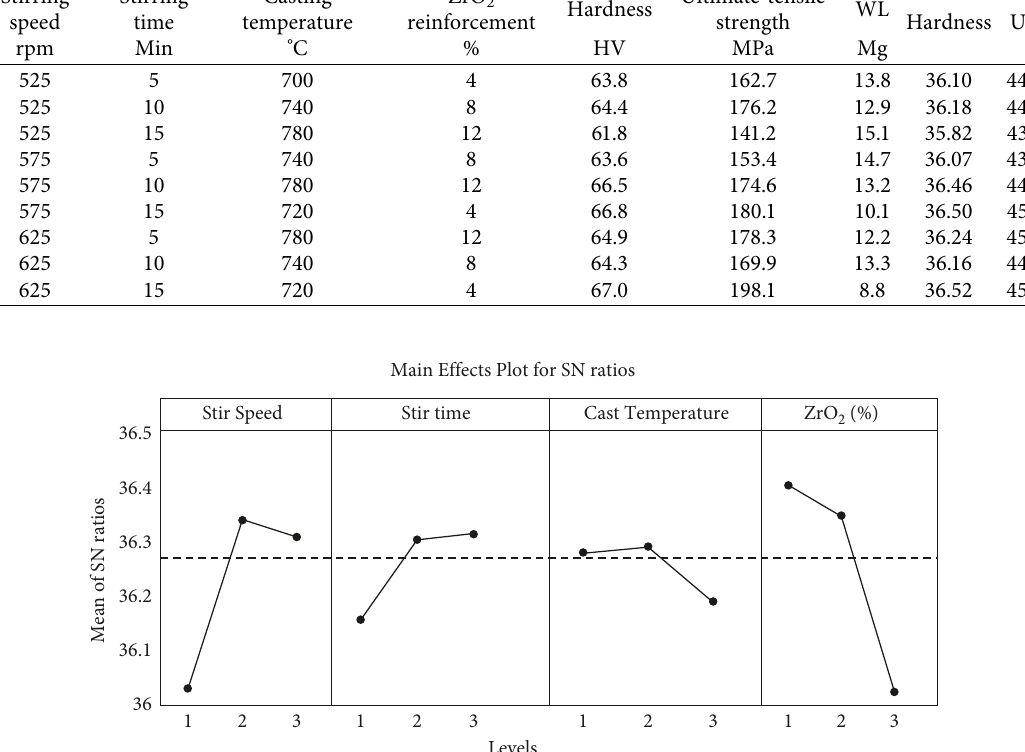
Table 2: Experimental Input and output settings of stir-casting progression. Trial.